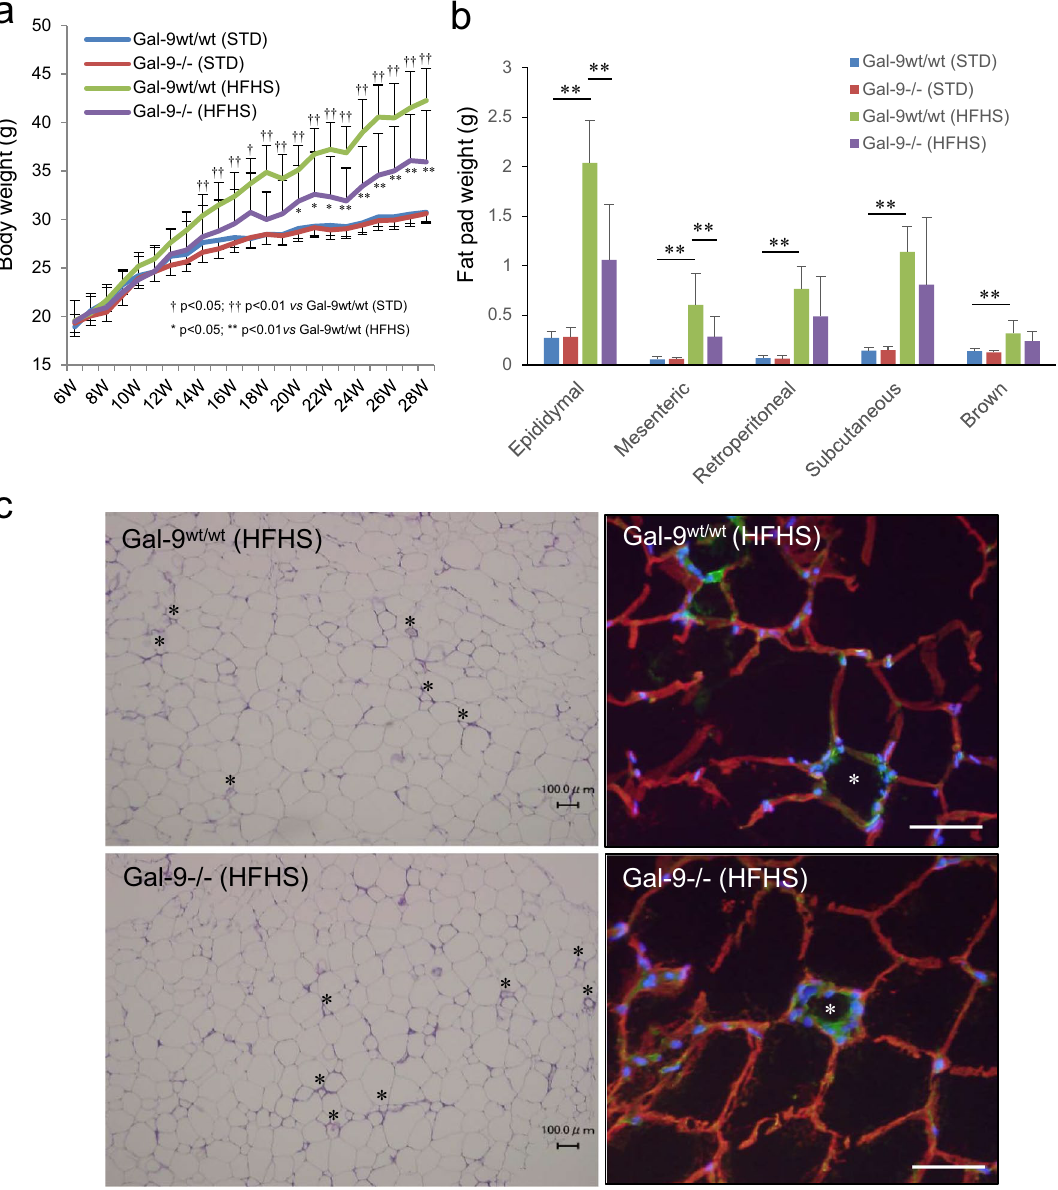
Figure 1. Body and fat pad weights and histology of epididymal adipose tissues. ( a ) Body weight in Gal-9 wt/wt and Gal-9 −/− mice fed with standard (STD) and high fat-high sucrose (HFHS) chow. Gal-9 wt/wt (STD), n = 9; Gal- 9 −/− (STD), n = 10, Gal-9 wt/wt (HFHS), n = 9; Gal-9 −/− (HFHS), n = 12. *, p < 0.05; **, p < 0.01 [Gal-9 wt/wt (HFHS) vs . Gal-9 −/− (HFHS)]; †, p < 0.05; ††, p < 0.01 [Gal-9 wt/wt (STD) vs . Gal-9 wt/wt (HFHS)]. One-way ANOVA with Tukey–Kramer. ( b ) Fat pad weight. Gal-9 wt/wt (STD), n = 9; Gal-9 −/− (STD), n = 8, Gal-9 wt/wt (HFHS), n = 8; Gal-9 −/− (HFHS), n = 9. *, p < 0.05; **, p < 0.01. One-way ANOVA with Tukey–Kramer. c . PAS stain and immunofluorescence study. *, Crown-like structures; Green, F4/80; Red, Perilipin; Blue DAPI. Bar = 100